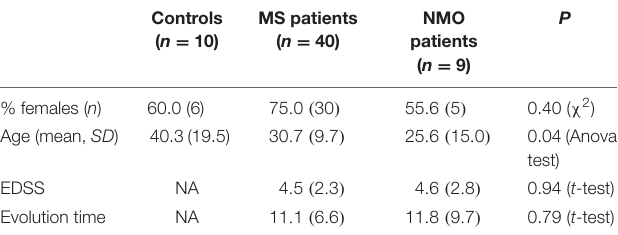
TABLE 4 | General characteristics of series studied.